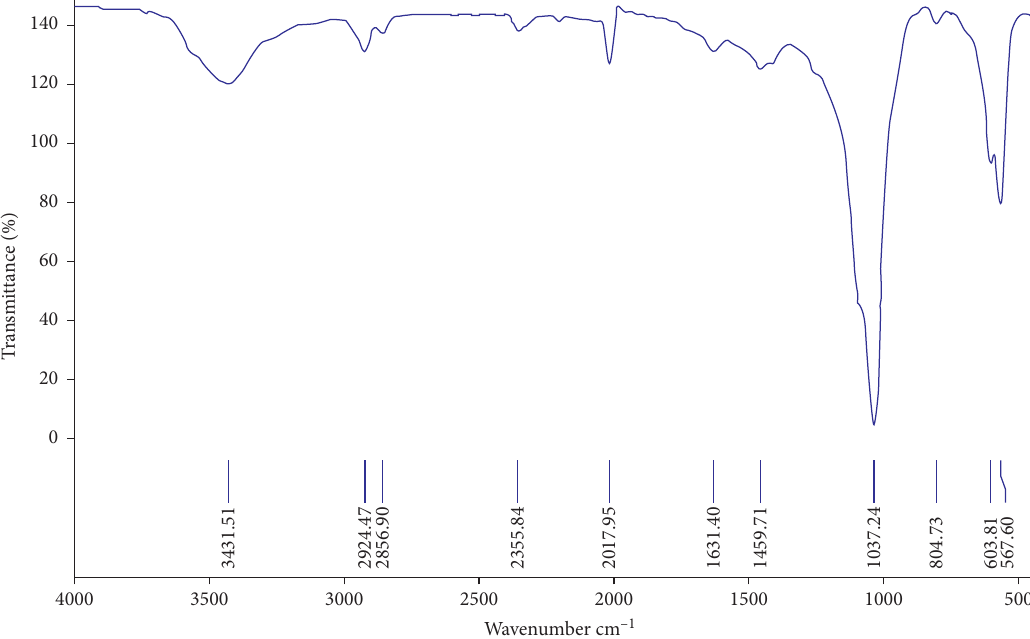
Figure 4: FTIR of ceramic microparticles. The FTIR showed a peak vibration at wavenumbers 1490cm − 1 /1640cm − 1 /3431.51cm − 1 and 1037.24 cm − 1 , which corresponded to OH-1 and PO4-3 stretches of HA/ β -TCP,